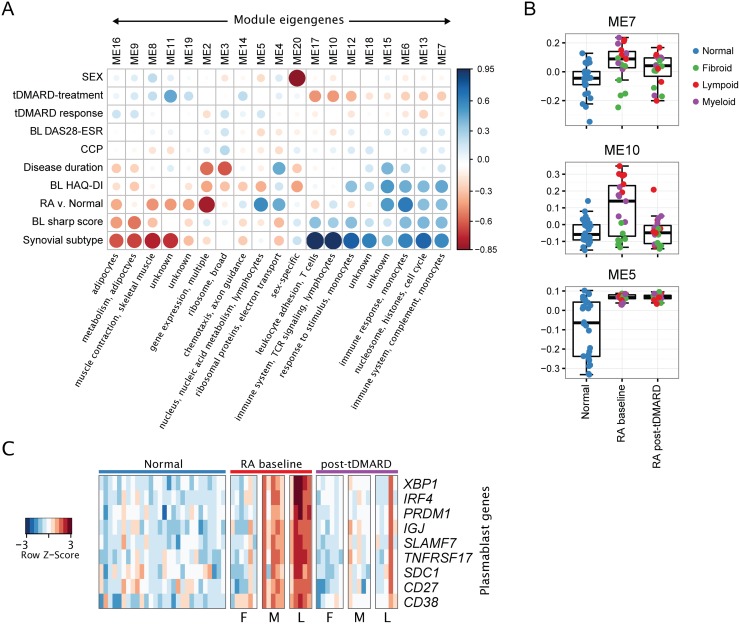
T cell activation and plasmablast/plasma cell differentiation pathways are down-modulated by tDMARD treatment in early RA synovial biopsies.(A) Co-expression modules are associated with disease and tDMARD treatment but not baseline DAS28-ESR or clinical response to tDMARDs. The spearman correlation coefficient between sample characteristics (y-axis) and module eigengenes (x-axis) are visualized. The size and color of each marker represents the correlation coefficient. Brief summarizations of the composition of each module are given. “BL” indicates baseline data was used. (B) Example module eigengenes are shown summarized by sample group. (C) Heatmap representation of plasmablast/plasma cell genes that are elevated in baseline RA samples and reduced by tDMARD treatment. The expression of these genes in normal samples is also shown. Samples are sorted on the x-axis by disease type, treatment, and inferred subtype (F: fibroid, M: myeloid, L: lymphoid).